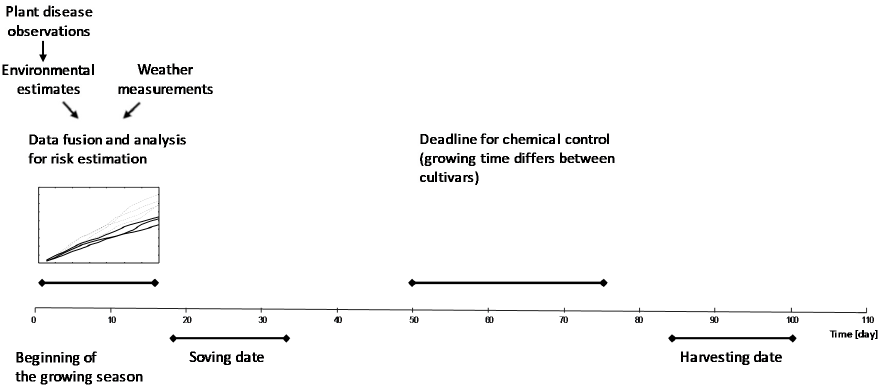
Figure 1. Feature generation and extraction for net blotch risk estimation.